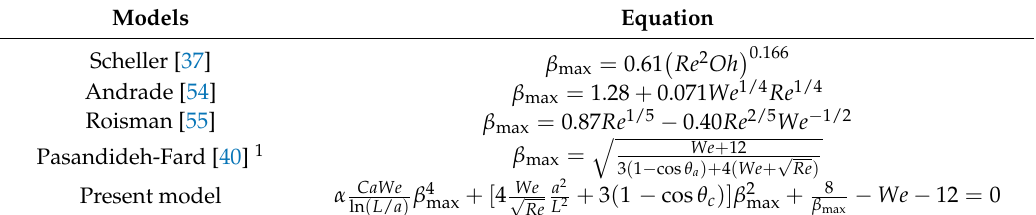
Figure 9. The comparison of experimental data and theoretical predictions of maximum spreading factor. The experiments were performed at various We including 5, 10, 15, 20, 25, 30, and 35. Table 1. Different proposed models for the maximum spreading factor.